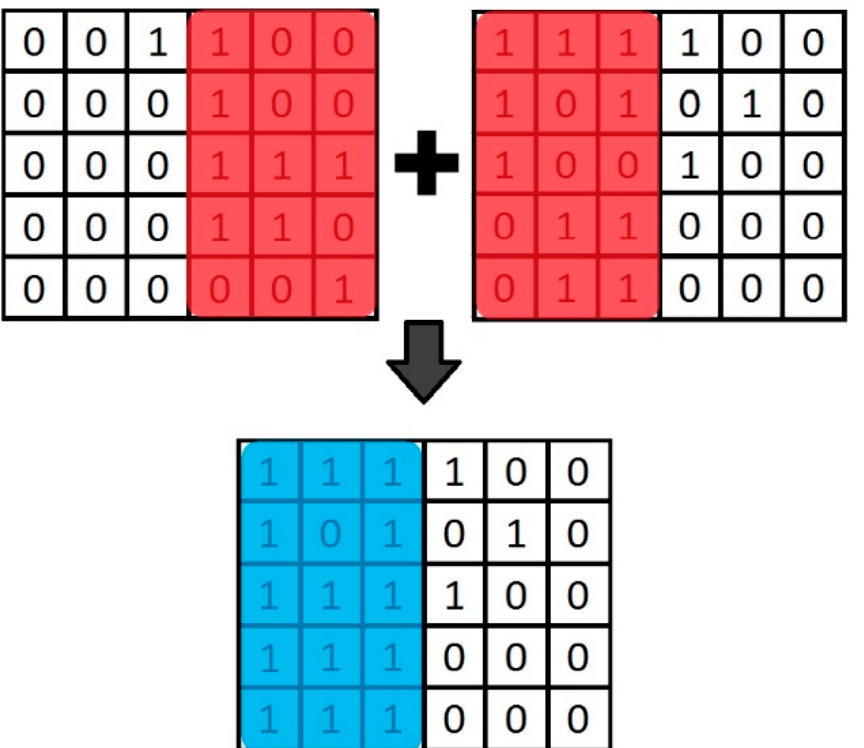
Figure 5. The concatenation procedure between two blocks.